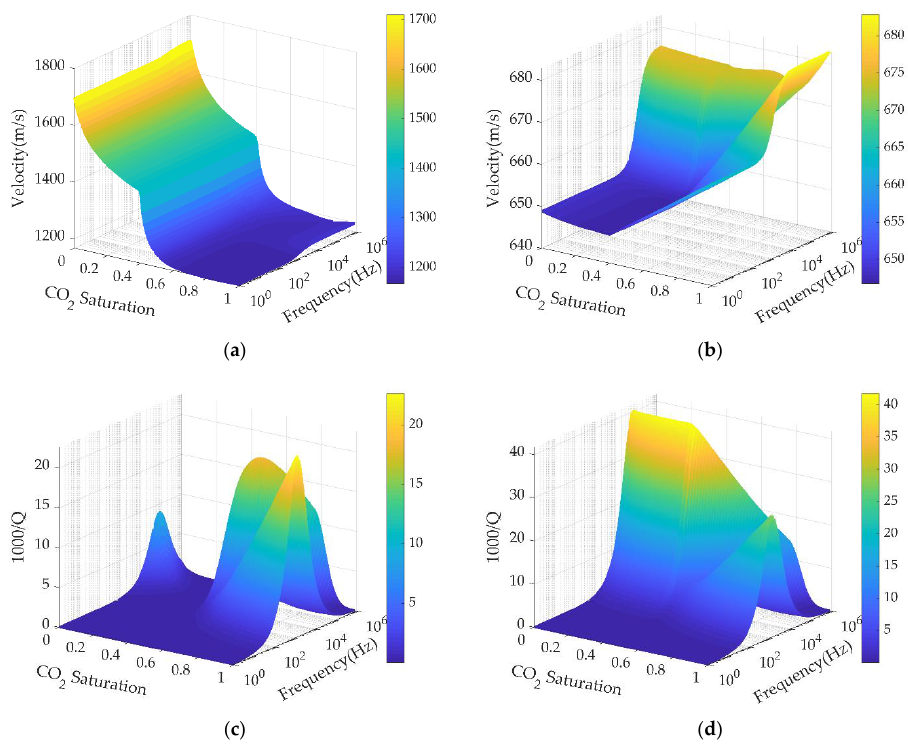
Figure 9. Effects of frequency and CO 2 saturation on the phase velocities and attenuations of waves: ( a ) P1 velocity; ( b ) S velocity; ( c ) P1 attenuation; ( d ) S attenuation.